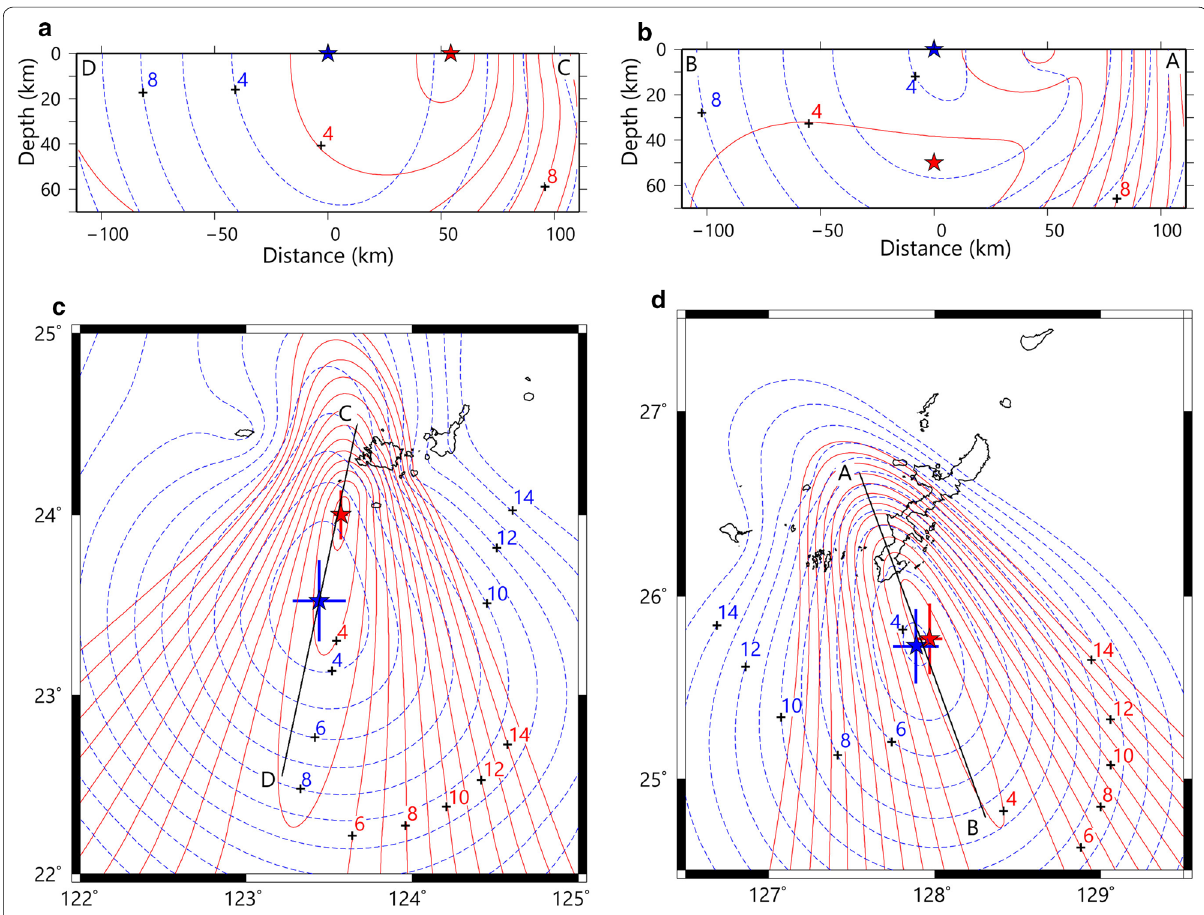
Fig. 7 Hypocenter error distribution of low-frequency earthquakes (LFEs) that occurred in the Okinawa and Yaeyama areas. a , b The vertical cross section of hypocenter error distribution. c , d The hypocenter distribution at the depth of 0 km. b and d Also show the hypocenter error distribu- tion of the event that occurred at 14:27 on June 23, 2010 (UT). a and c Also show the hypocenter error distribution of the event that occurred at 13:41 on July 23, 2004 (UT). Red contours show the root-mean-square (RMS) differences (in seconds) between the observed and predicted S-phase travel times of the LFEs. Blue contours show the RMS differences (in seconds) between the observed and predicted S-wave travel times and S–P time delays. Stars show the hypocenters obtained by the hypocenter